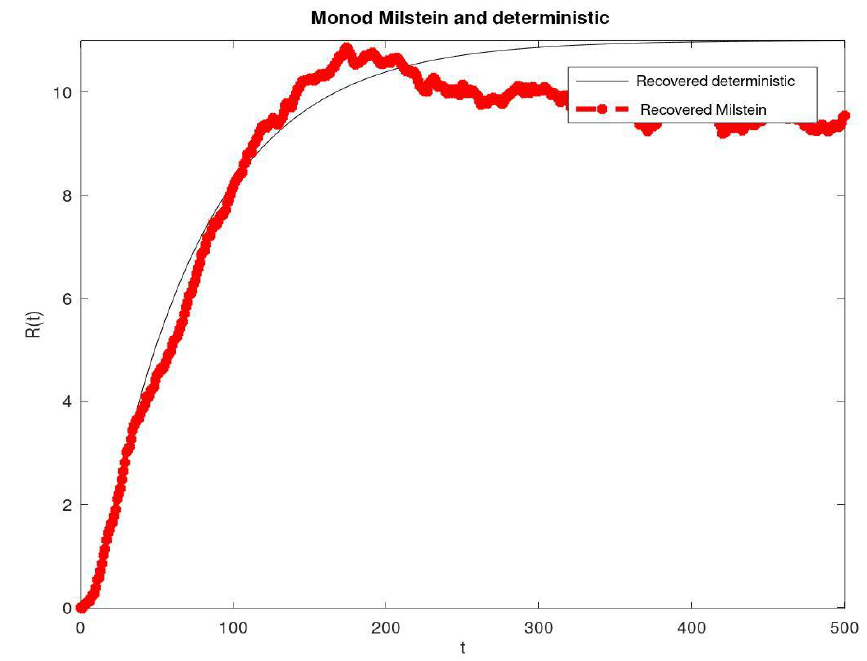
Figure 4. Plot of the dynamic behaviors of the susceptible and infected populations under the intervals (cid:101) β = 0.03 and (cid:101) γ = 0.015 .